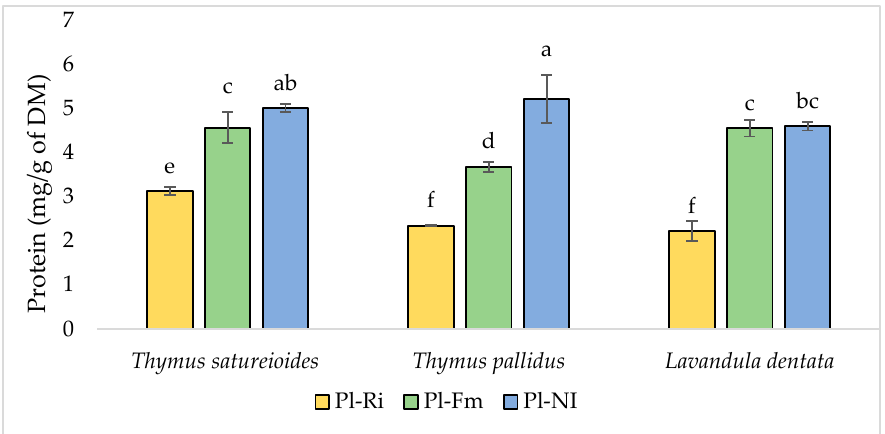
Figure 4. Soluble sugar content (mg/g DM) in Thymus satureioides (Ts), Thymus pallidus (Tp), and Lavandula dentata (Ld), non-inoculated (NI) or inoculated with Rhizophagus irregularis (Ri) or Funneliformis mosseae (Fm) after 4 months of culture under greenhouse conditions. Bars followed by the same letter are not significantly different according to Tukey’s HSD test ( p < 0.05). The protein content varied significantly ( p < 0.0001) depending on the AMF and AMP species. The total protein content in the three AMP species was more than 1.5 times higher in I-AMP than in NI-AMP (Figure 5).